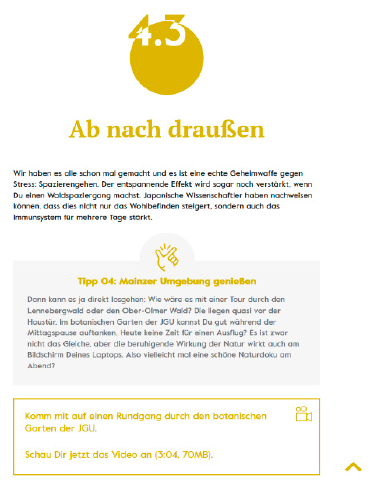
Figure A2. Chapter 4“Promoting relaxation”.